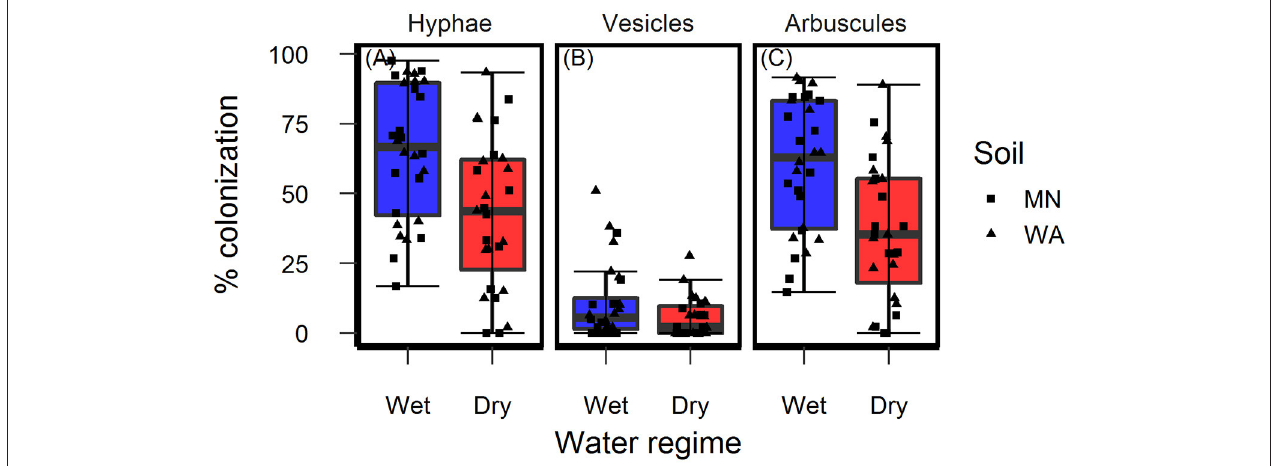
FIGURE 4 | Colonization of AMF (A) hyphae, (B) vesicles, and (C) arbuscules on Asclepias speciosa plants growing in live soil exposed to dry and wet watering treatments.